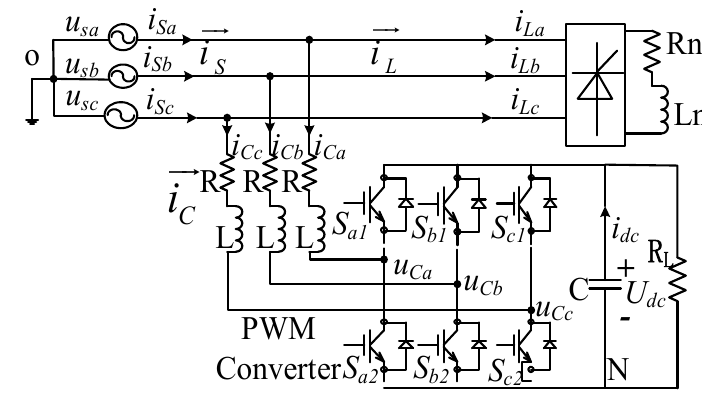
Figure 1. Topology of shunt-type active power filters (APF).